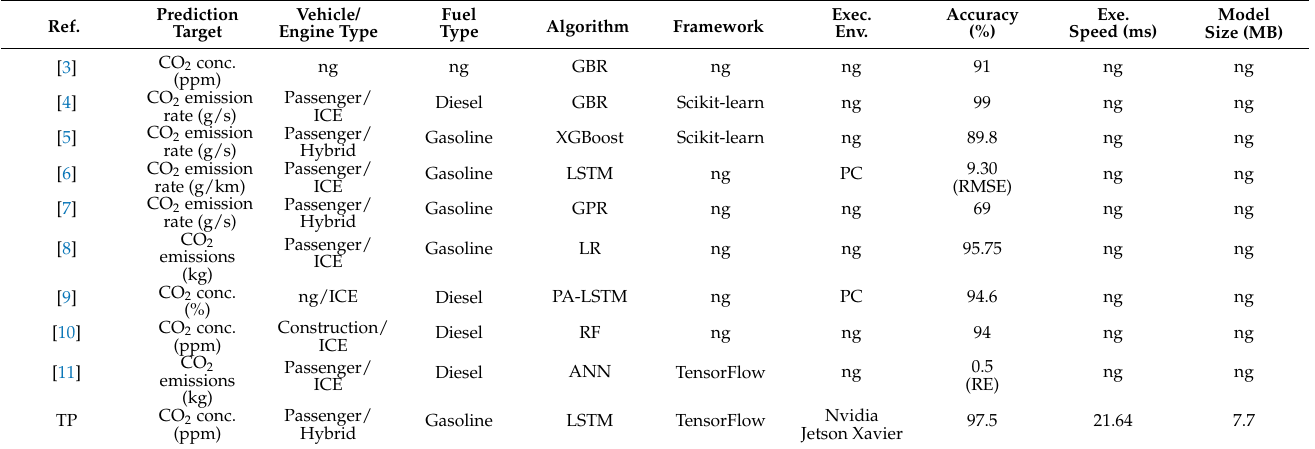
Table 1. Comparison of prediction techniques for vehicle CO 2